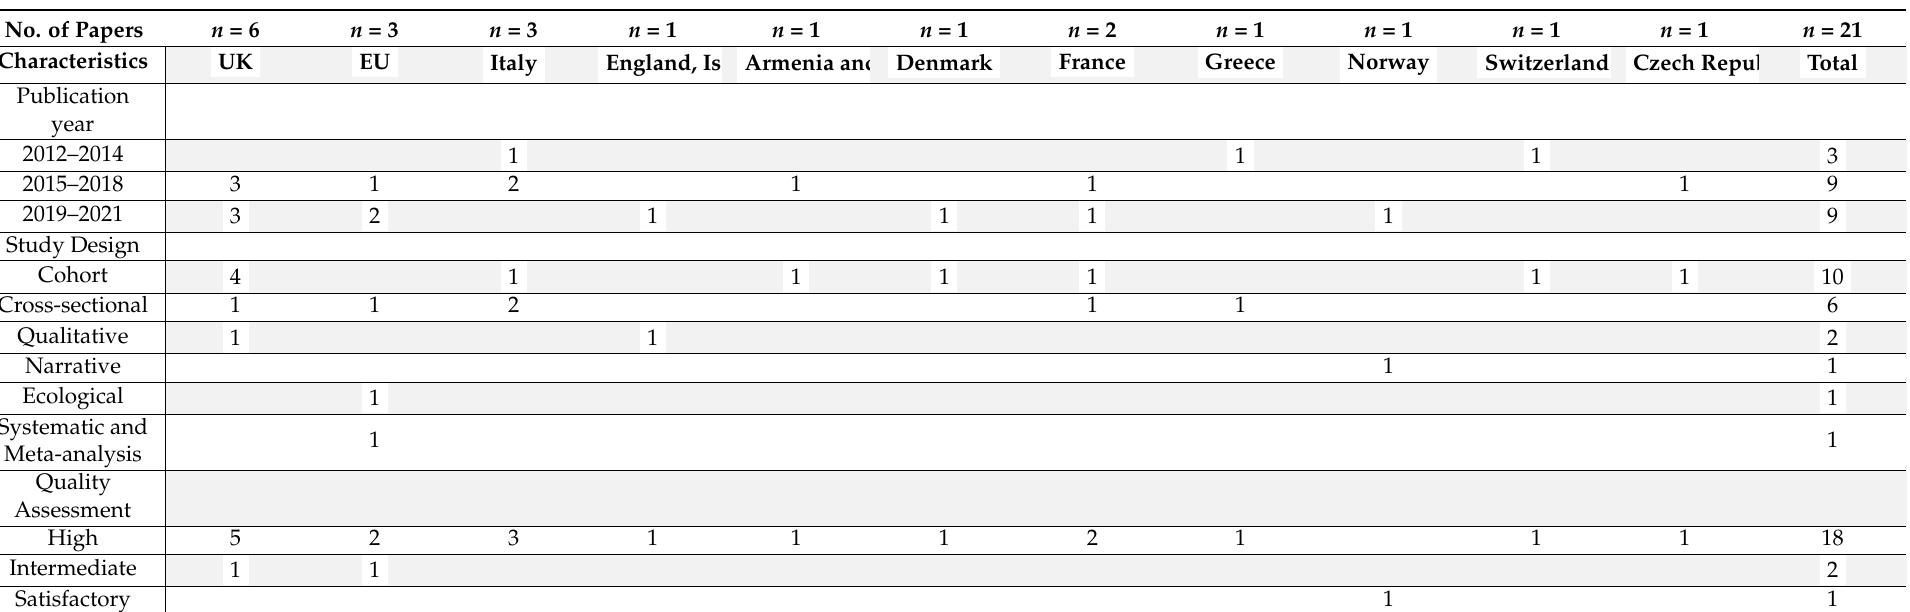
Table 2. Characteristics of selected articles ( n =